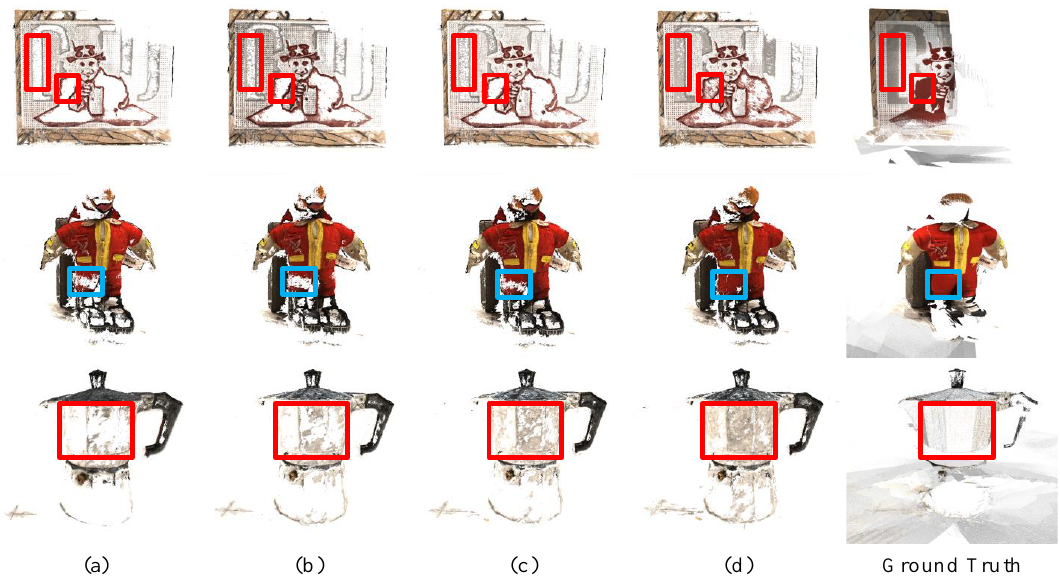
Figure 10. Comparison of reconstruction results after adding each module. ( a – d ) has the same meaning as in Table 2.